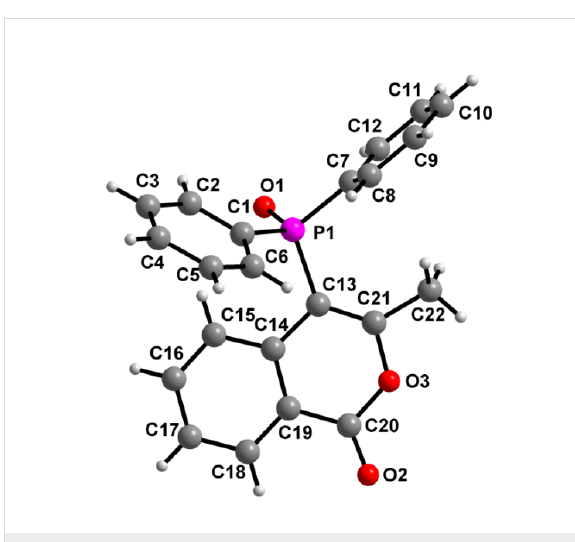
Scheme 7: Synthesis of phosphinoylisocoumarins from functionalized allenes.